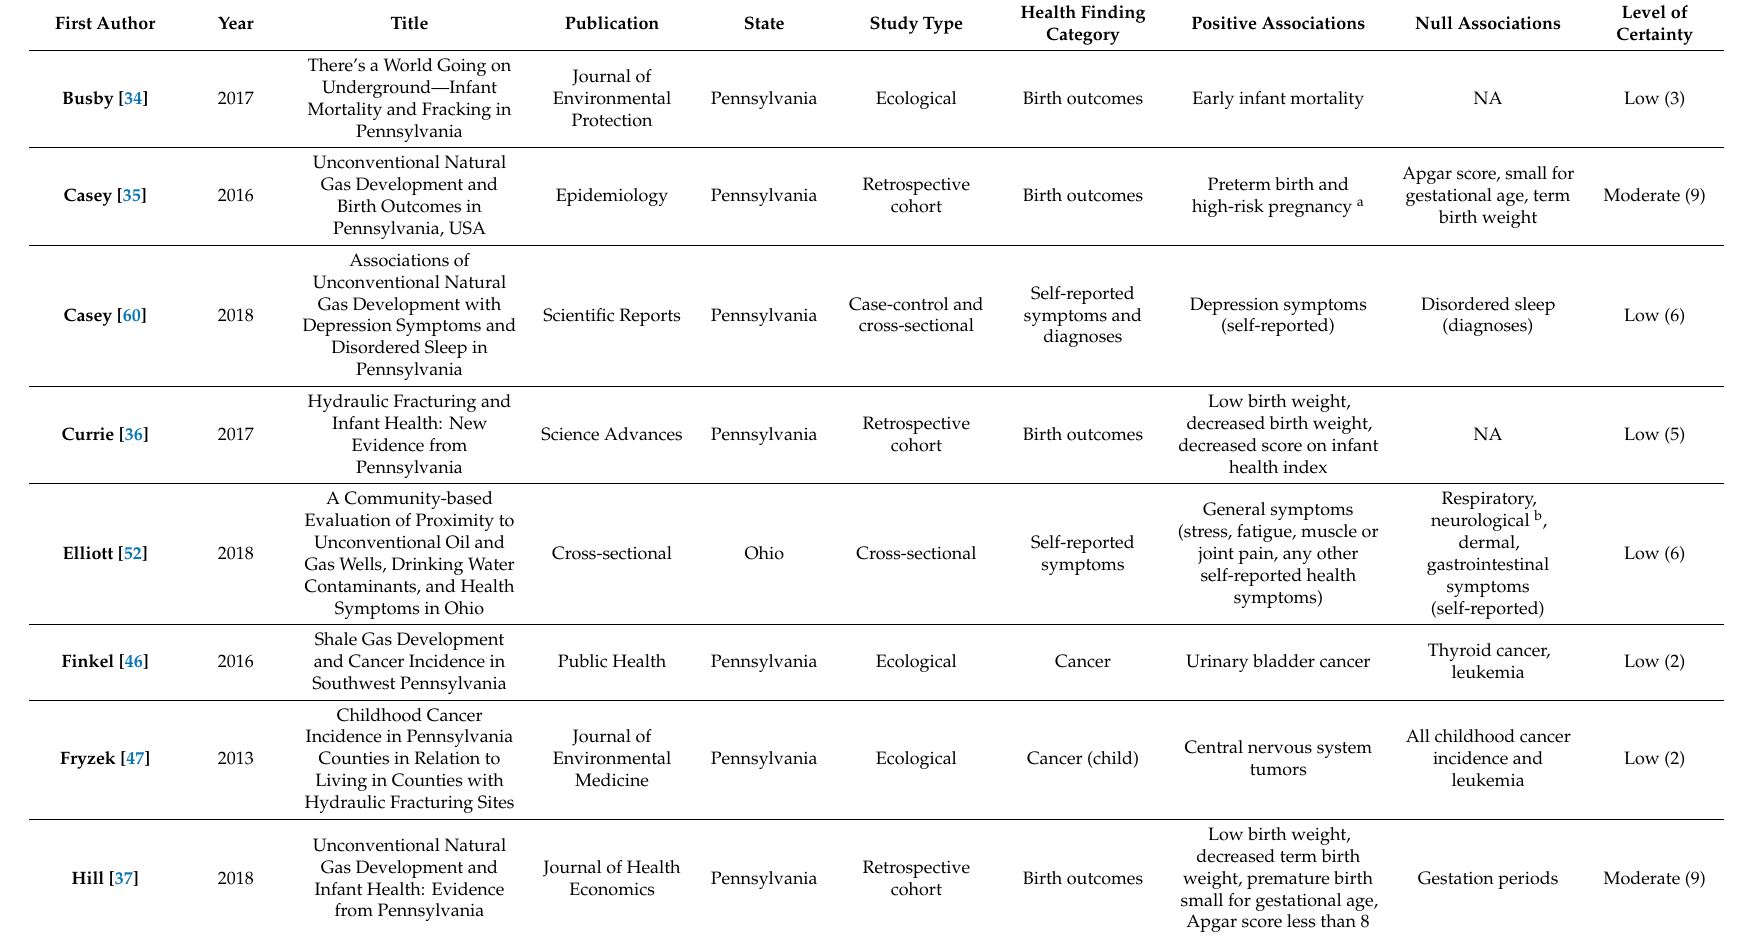
Table 3. Summary details of epidemiologic studies included in this systematic